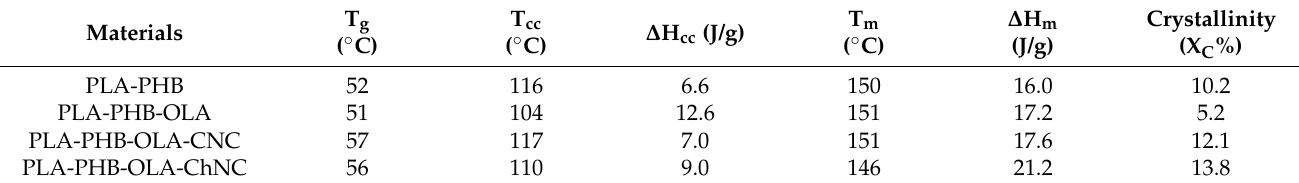
Table 4. Thermal properties of blown film materials obtained from DSC first heating